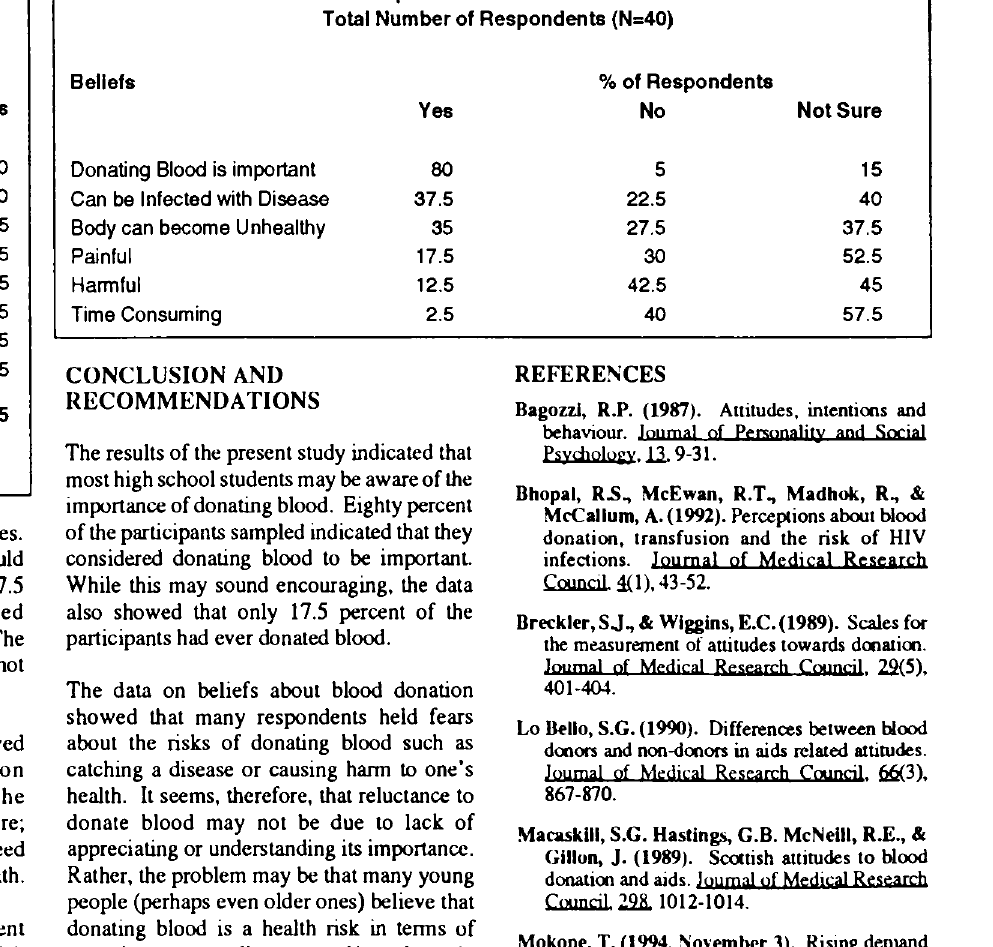
TABLE 2: Participants’ Beliefs about Blood